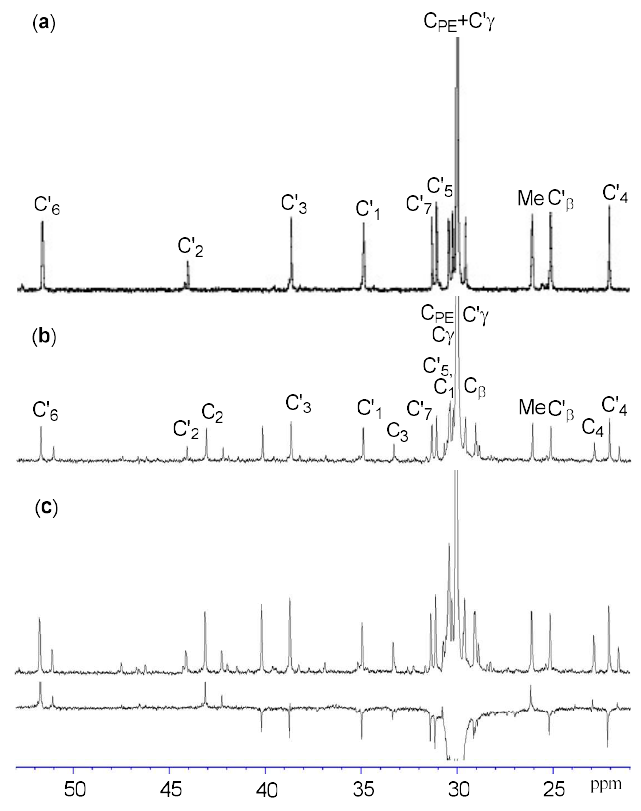
Figure 10. 13 C NMR spectra and the dept spectrum for poly(ethylene- co -1-MeCPE)s prepared by: ( a ) ( t BuC 5 H 4 )TiCl 2 ( O -2,6-Cl 2 C 6 H 3 )-MAO catalyst system ( 8 ), ( b , c ) (1,2,4-Me 3 C 5 H 2 )TiCl 2 (O-2,6-Cl 2 C 6 H 3 ) ( 7 )-MAO catalyst system [34].